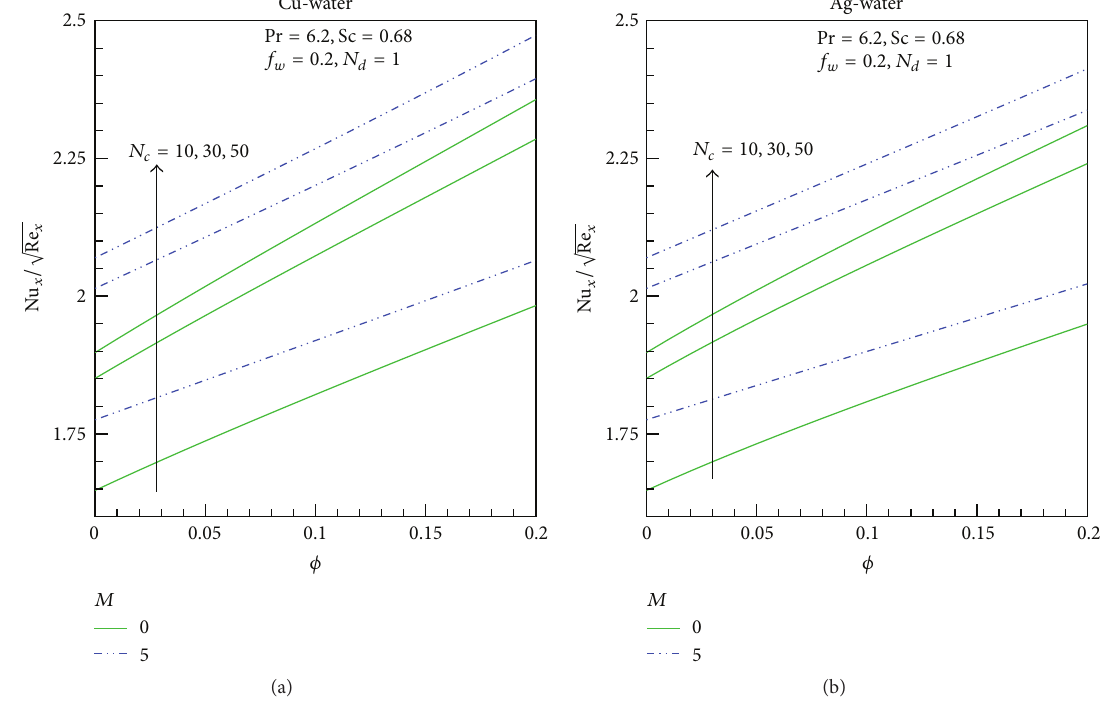
Figure 8: Variation of dimensionless heat transfer rate with 𝑁 𝑐 , 𝑀, and 𝜙 .